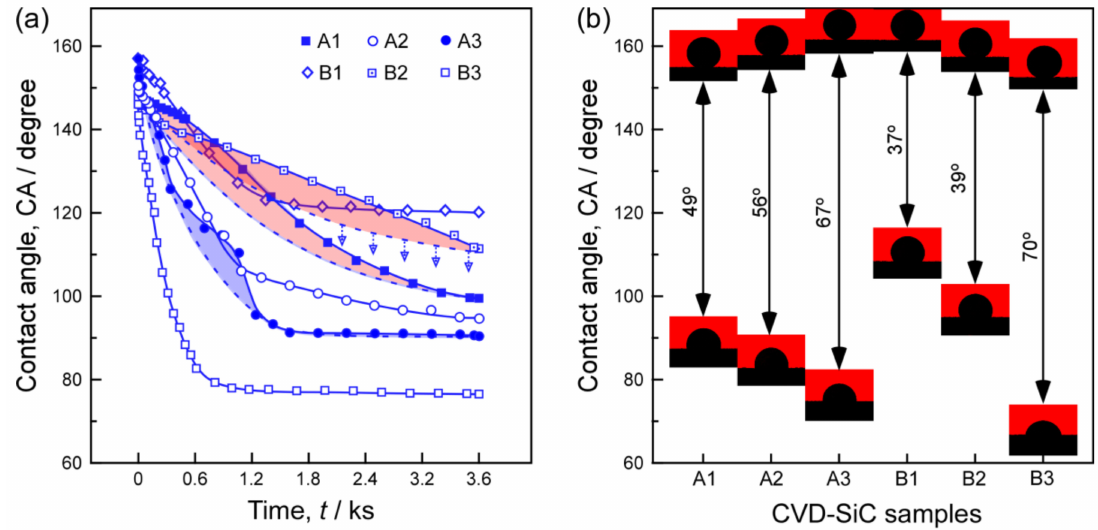
Figure 7. Wettability of the CVD-SiC samples by molten aluminum with time. ( a ) contact angles changes with time; ( b ) the variations in initial (upper panel) and final (bottom panel) contact